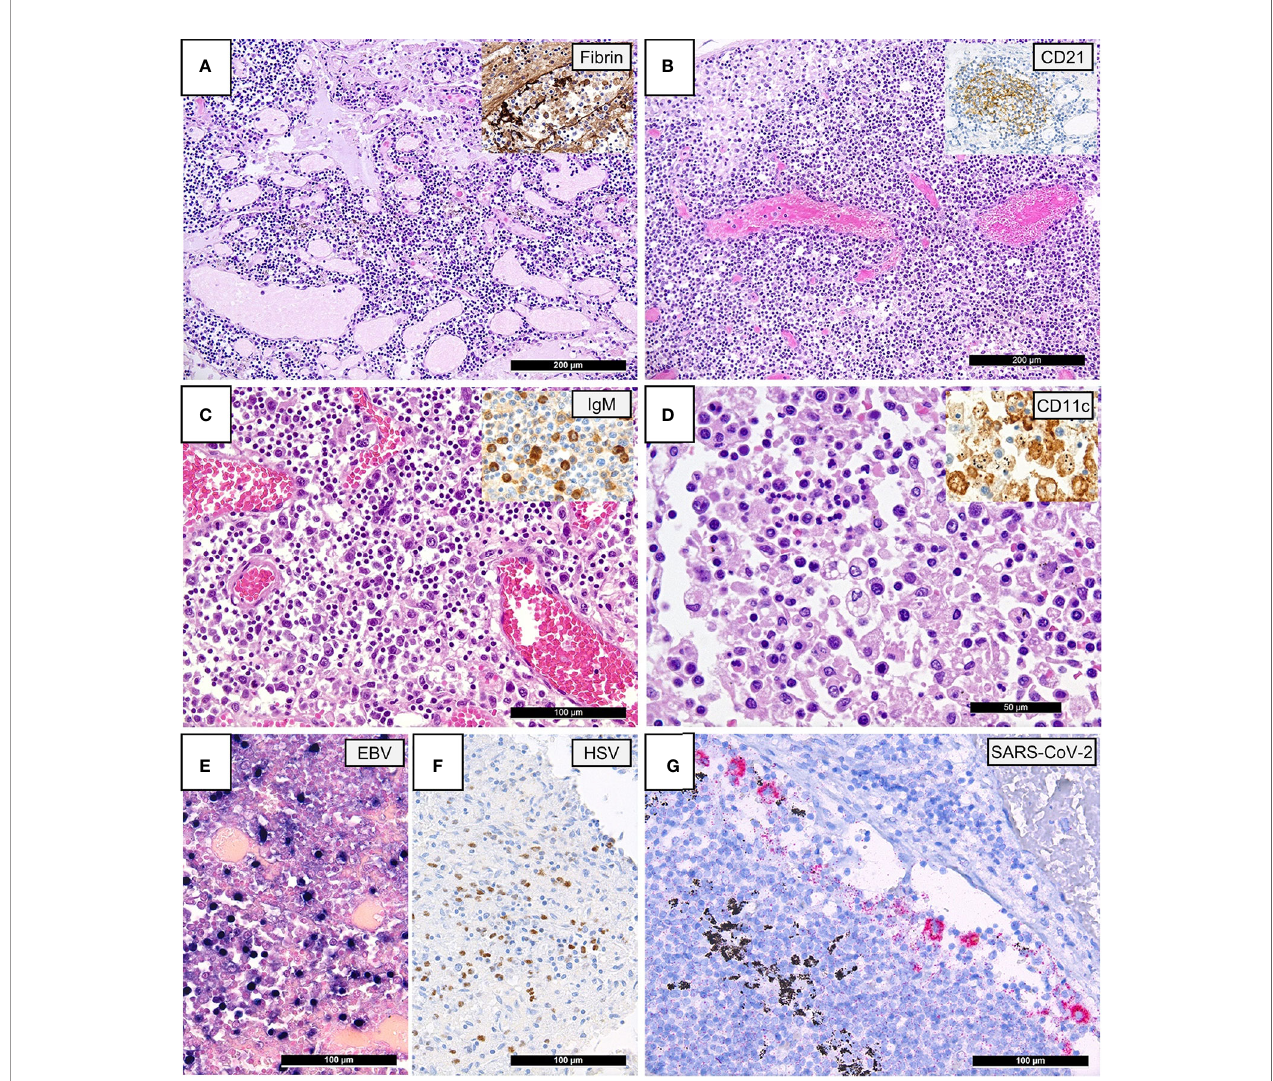
FIGURE 1 | Lymph Node Histomorphology in COVID-19. (A) Overview of a lymph node draining a COVID-19 lung with edema and capillary stasis (H&E; 100x); inset: fi brin microthrombus in a dilated subcapsular sinus (immunoperoxidase; 100x). (B) Severe capillary stasis and expansion of the paracortex without discernable germinal centers (H&E; 100x); inset: disrupted, CD21+ germinal center network (immunoperoxidase; 100x). (C) Proliferation of extrafollicular plasmablasts (H&E; 200x); inset: expression of IgM by plasmablasts (immunoperoxidase; 360x). (D) Hemophagocytosis in the sinus of a lymph node (H&E; 360x); inset: positivity for CD11c in histiocytes with hemophagocytosis (immunoperoxidase; 400x). (E) Increased amount of EBV-infected B-cells in a lymph node of a COVID-19 patient (EBER ISH; 280x). (F) Increased amount of HSV infected B-cells (immunoperoxidase; 280x). (G) SARS-CoV-2 positivity in sinus histiocytes as detected by immunohistochemistry for the SARS-CoV-2 N-antigen (immunoperoxidase with 3-amino-9-ethylcarbazole used as a chromogen;